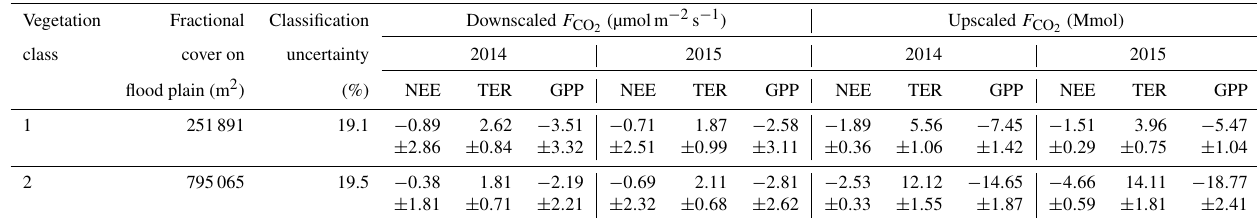
Table 1. Outcome of downscaling and upscaling carbon dioxide fluxes for the comparison period (18 June to 24 September) in both 2014 and 2015. The mean downscaled fluxes ( ± standard deviation) refer to the individual fluxes of both vegetation classes (Fig. 8). Their aggregation yielded cumulative fluxes, whose projection on their corresponding areas on the flood plain in turn returned upscaled fluxes ( ± combination of cumulative flux error and classification error). The uncertainty metrics derived from the comparison of the applied vegetation map, which was obtained through supervised classification of aerial imagery, with another vegetation map that was acquired via ground-based surveys (Rößger et al., 2019a).